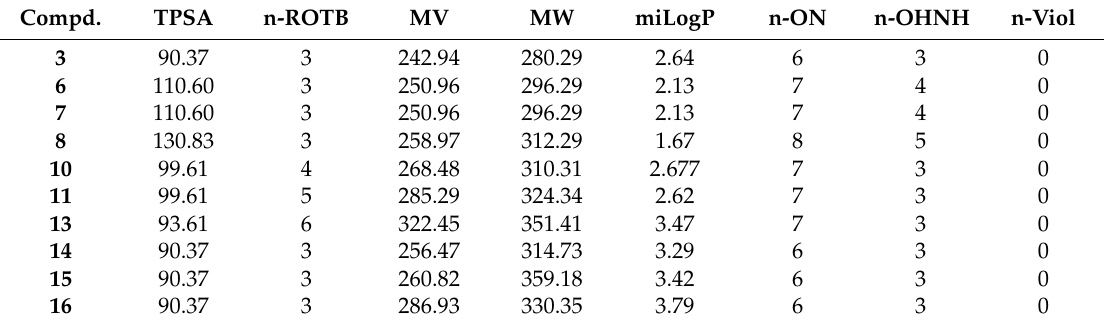
Table 2. In silico physico-chemical properties (ADME) of active compounds 3 , 6 – 8 , 10 , 11 , 13 – 16 .